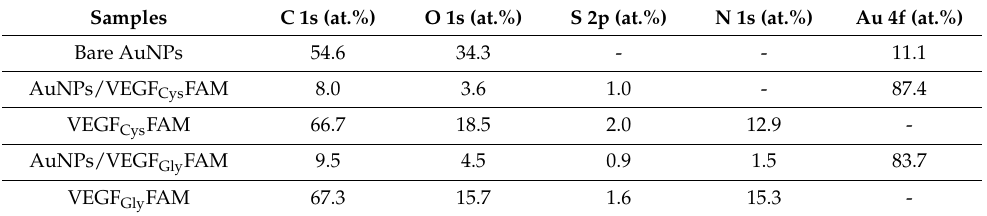
Table 1. Surface atomic composition of AuNPs before and after the functionalization with peptides.